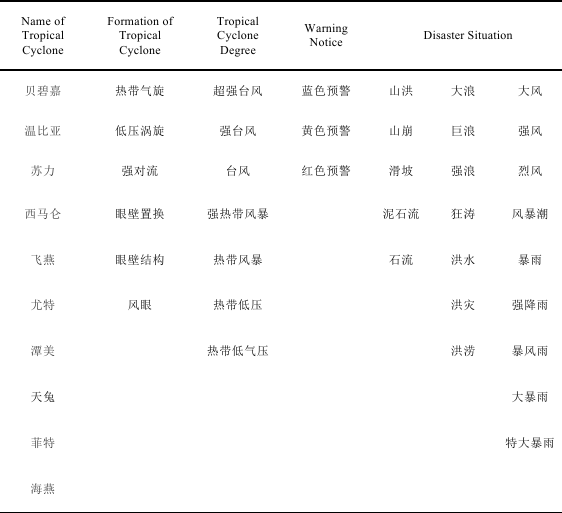
Table 3. The keywords for Weibo data filtering